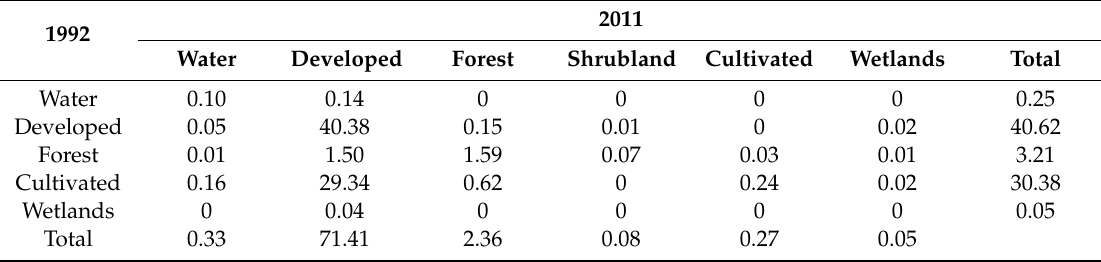
Table 1. Land use change transition matrix in LEC from 1992 to 2011 (km 2